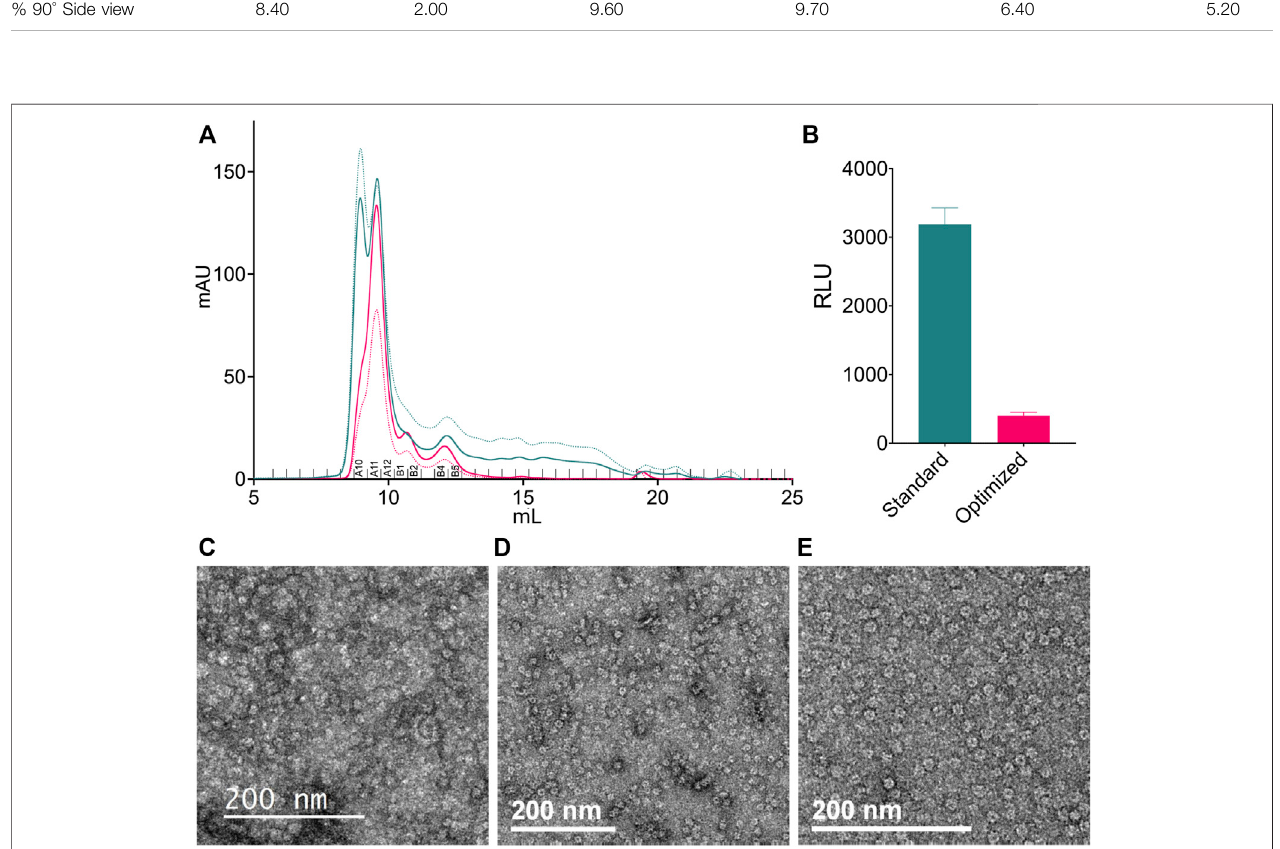
FIGURE5| Samplepreparationoptimization. (A) AnalyticalSECpro fi lesofthestandard(teal)andoptimized(pink)methodsofpuri fi cation.Sampleswereanalyzed using a Superdex 200 Increase 10/300 GL SEC column. Solid lines show the absorbance at 280 nm. Dotted lines show the absorbance at 260 nm. Fractions corresponding to Table 1 ; Supplementary Figure S1 are labeled above the x -axis. (B) Relative luminescence units (RLU) of nucleotides from fraction A11 of both puri fi cation protocols. Samples were prepared using only the detection step of the ADP-Glo assay. Error bars represent 95% con fi dence interval ( n = 3). (C,E) NS screening of different CDC48A samples. (C) CDC48A samples that were thawed after pooling and concentrating for storage. (D) CDC48A sample taken fresh from off- center fractions of the hexameric peak (primary peak). (E) CDC48A sample taken fresh from the center of the hexameric